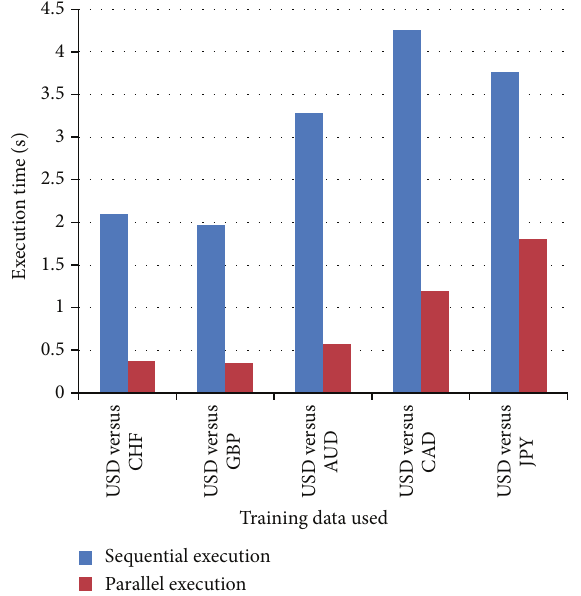
Figure 7: Performance improvement through parallel execution.